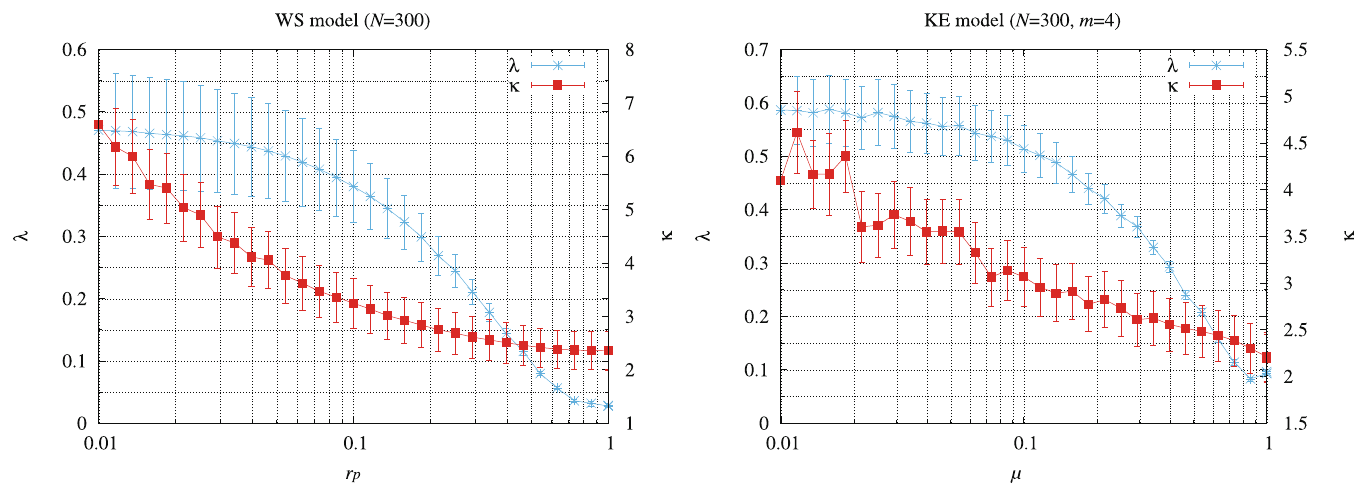
Fig 12. Relationships between the clustering coefficient ( � λ ) and the average shortest hop distance between nodes ( � κ ) if we change (a) the rewiring probability ( r p ) for the WS model, and (b) the probability ( μ ) that adjusts the clustering coefficient for the KE model. In these simulations, we constructed 30 different networks for each model, and averaged the